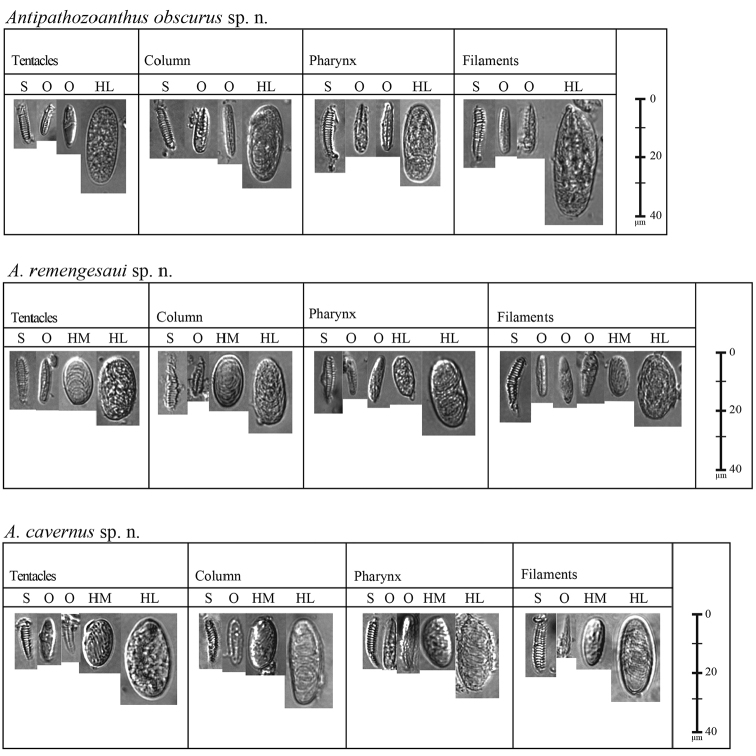
Cnidae in the tentacles, column, pharynx, and filament of Antipathozoanthus
obscurus sp. n., A.
remengesaui sp. n. and A.
cavernus sp. n., respectively. Abbreviations: (HL) holotrich large, (HM) holotrich medium, (O) bastrichs or mastigophores, (S) spriocysts.